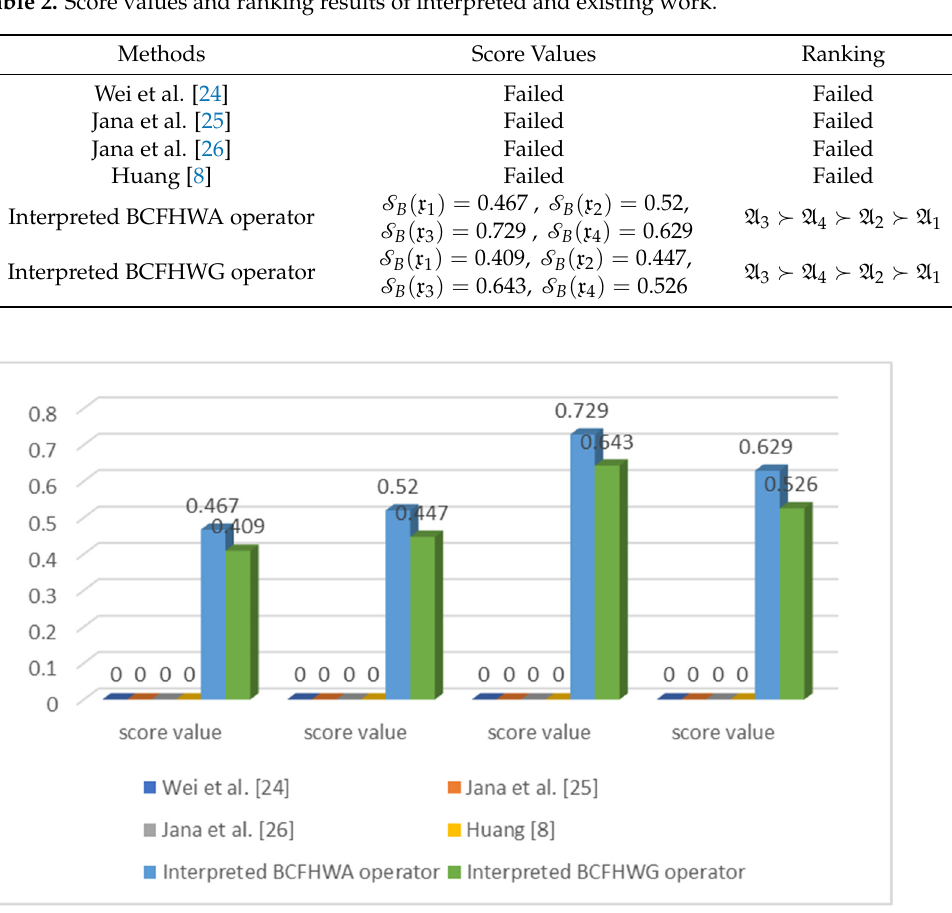
Figure 1. The graphical depiction of the score values of existing and interpreted work.